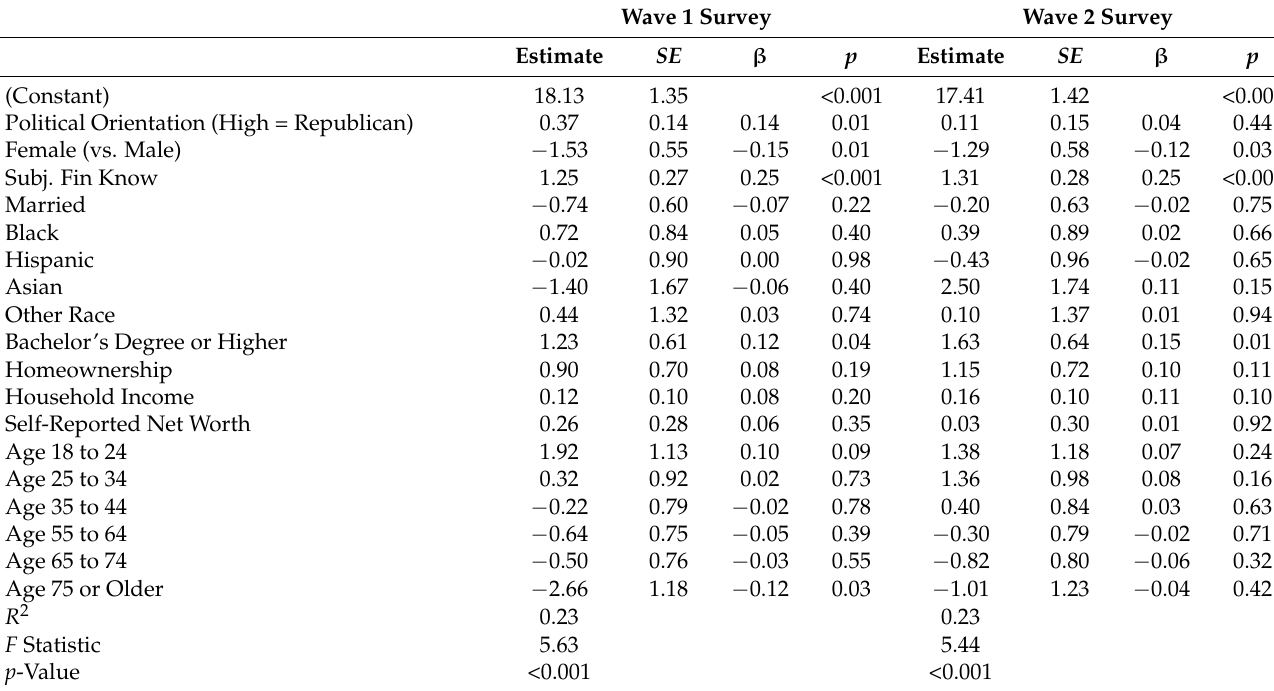
Table 5. OLS regression results describing financial risk tolerance